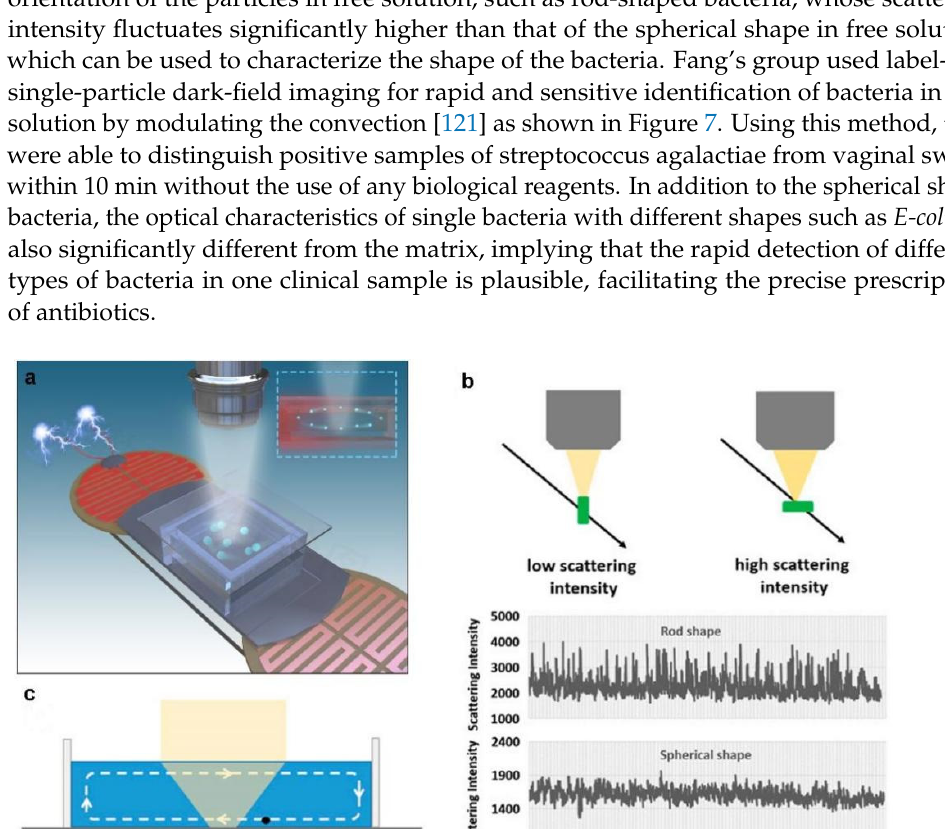
12 of 20 Figure 6. Schematic of detection of E. coli with dark-field microscopy. ( a ) Samples containing E. coli. (b) an anti- E. coli antibody functionalized gold surface. ( c ) Dark-field microscopy is used to inspect the surface of the gold sheet after 75 min incubation with the field sample and rinse with phosphate buffer solution, enlarging the image. ( d ) Statistical image analysis was used to count the bacteria captured by the antibodies [40]. Adapted with permission from Ref. [40]. Copyright © 2019 MDPI Creighton et al. identified Treponema Pallidum under optical microscopy with dou- ble-reflection and single-reflection dark-field condensers based on spirochetes of bacterial characteristic morphology and locomotion criteria. Ideally, this method can identify Trep-